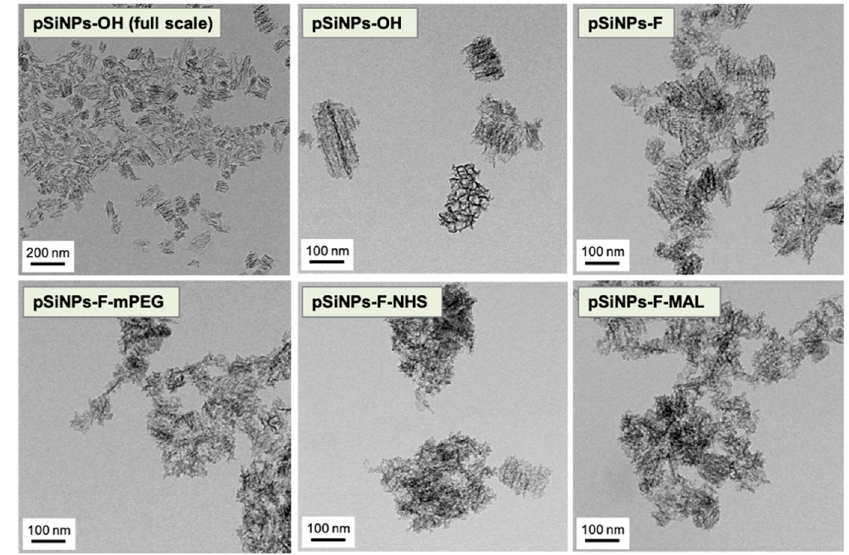
Figure 3. Transmission electron microscopy (TEM) images of oxidized pSiNPs ( pSiNPs-OH ) and its surface-functionalized samples. Scale bar is indicated in each figure.